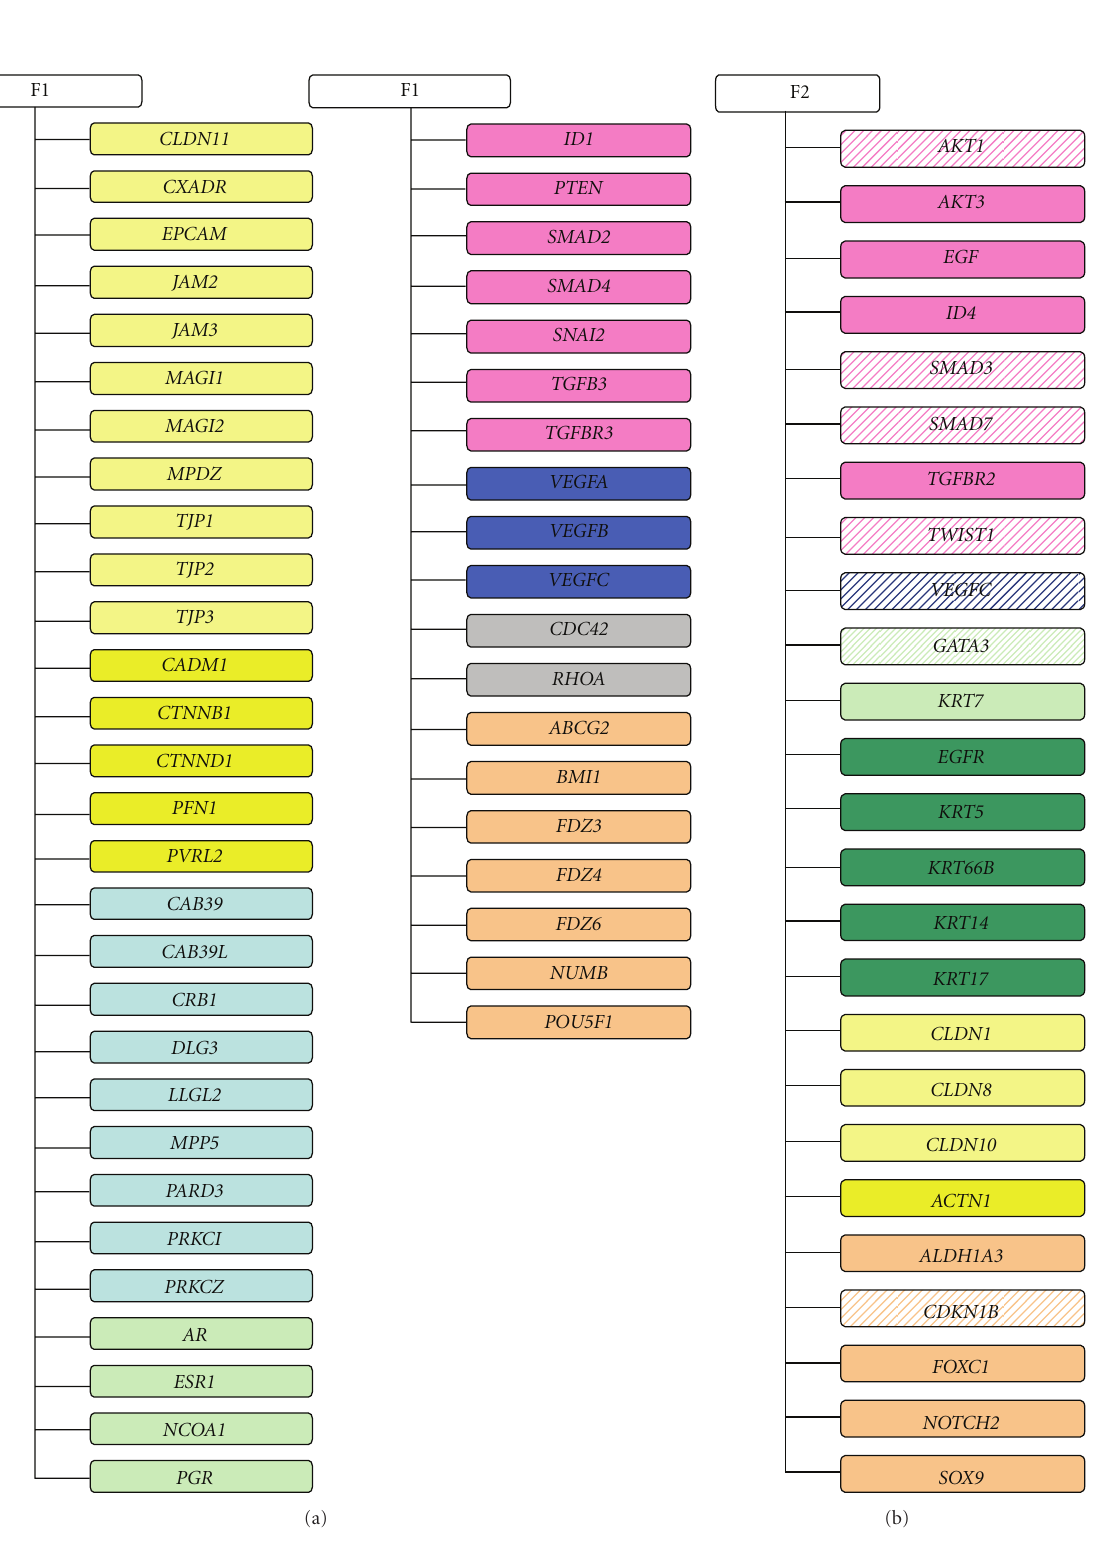
Figure 1: Factor analysis in DCIS subgroup. Schematic representation of genes with a loading value < | 0 . 6 | characterizing the first (F1) and the second factor (F2). Solid color indicates a positive loading value whereas dashed color indicates a negative loading value. Color correspondence: light yellow , tight junction components; dark yellow , adherens junction components; light blue , polarity complexes components; dark blue , angiogenesis; orange , cell-fate decision; light green , luminal markers and hormone steroid; dark green , basal markers; pink , epithelial-mesenchymal transition, grey , GTPase family